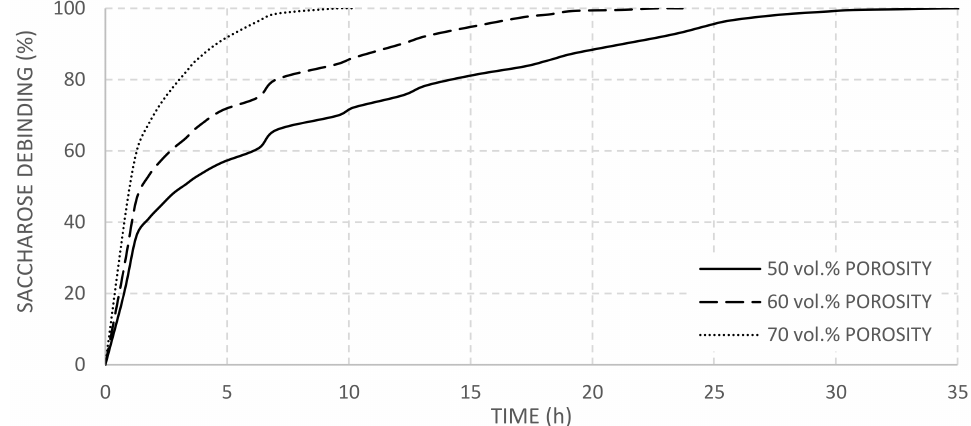
Figure 3. Saccharose dissolving rate for different design porosity foams.